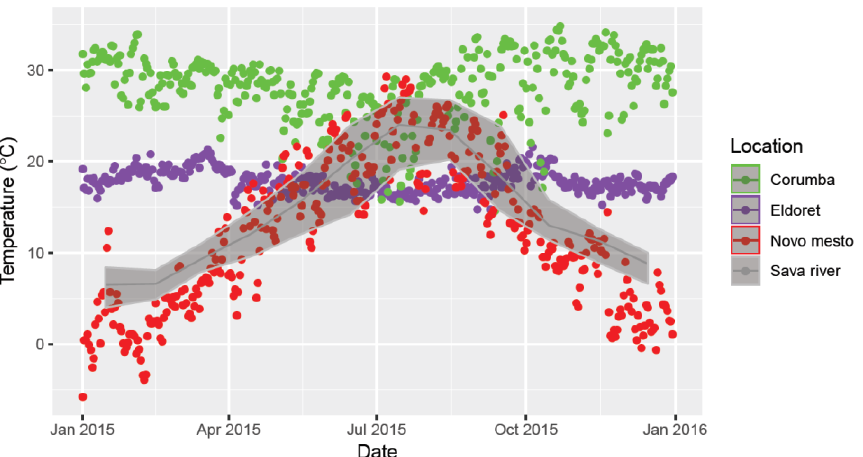
Figure 3. Comparisons of daily mean air temperatures in 2015 at the Novo Mesto meteorological station near Čatež (Slovenia), in Corumba (Brazil), and in Eldoret, (Kenya). Monthly mean water temperatures at the Jesenice na Dolenjskem recording site on the Sava River, 5 km downstream of the study site (Prilipe, Slovenia), obtained from the Slovenian Environment Agency are shown by the dark grey area: average temperature (dark grey line) and minimum and maximum temperatures (light grey lines).